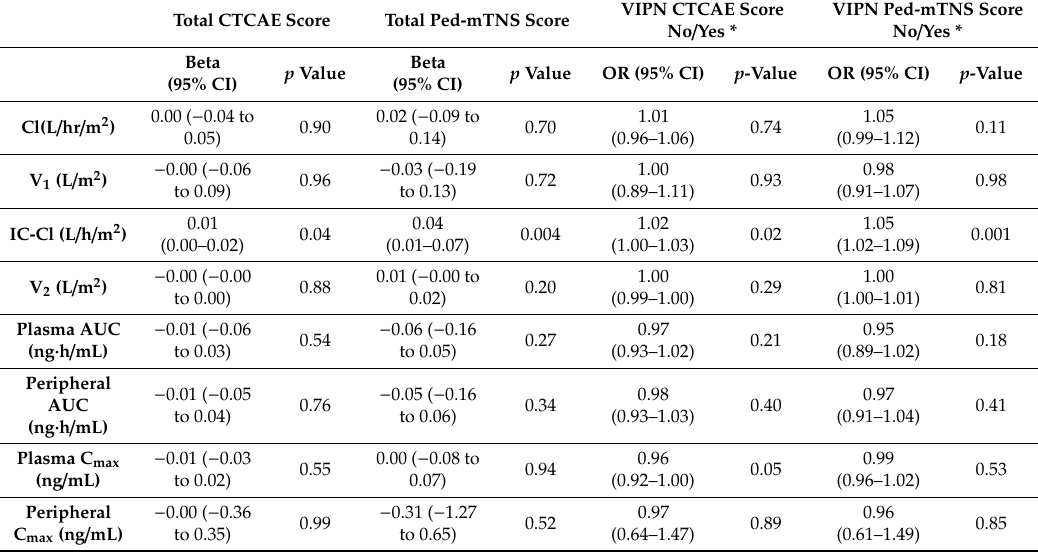
Table 4. Association between pharmacokinetic parameters and vincristine induced peripheral neuropathy, additionally corrected for age, sex, VCR dose per m 2 , disease, concurrent azole-antifungal treatment, and self-declared